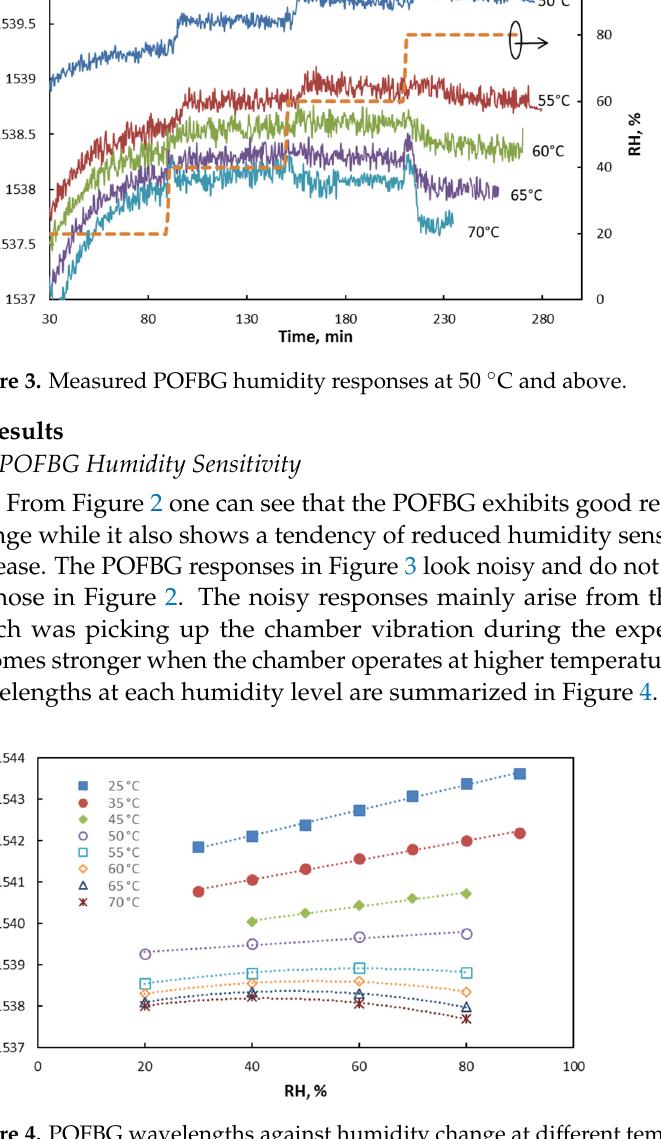
Figure 4. POFBG wavelengths against humidity change at different temperatures.